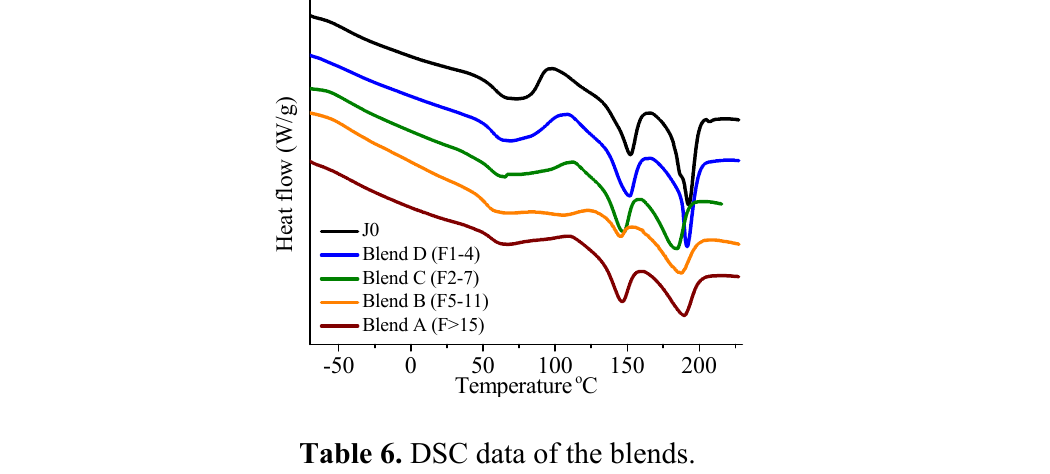
Figure 12. Differential scanning calorimeter (DSC) traces of the blends.